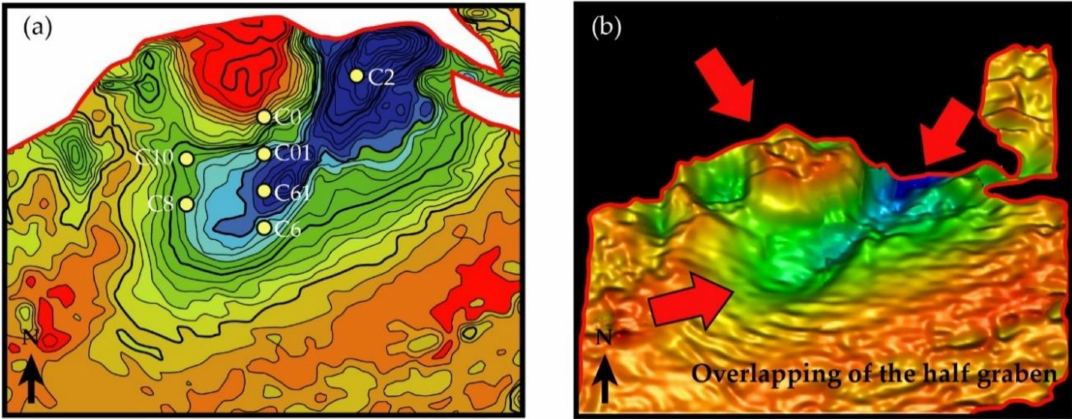
Figure 9. ( a ) Reconstruction of the paleogeomorphology for the Es 3L Formation in the Chezhen area. ( b ) Three-dimensional reconstruction of the paleogeomorphology for the Es 3L Formation in the Chezhen area. Blue to red indicates the paleoeleva- tion from low to high. Red arrows indicate the directions of